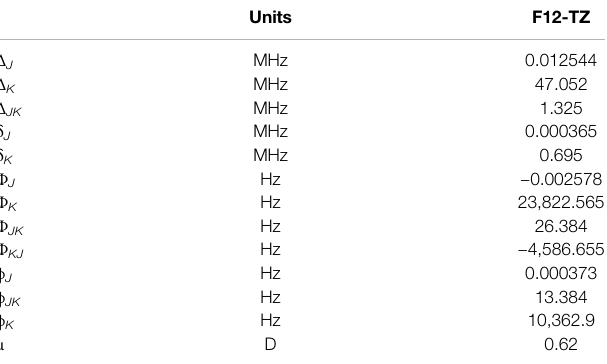
TABLE 7 | Quartic and sextic constants for HMgNH 2 .